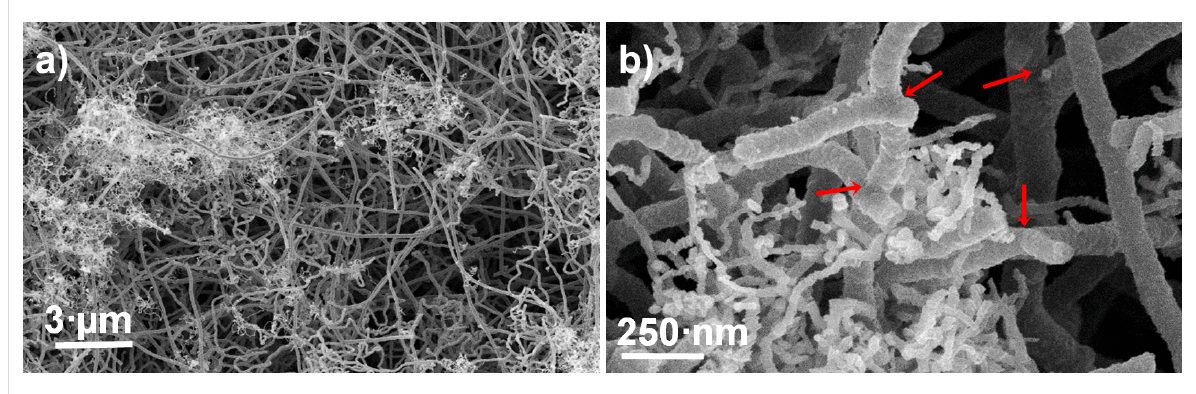
Figure 2: SEM micrographs showing the entangled structure of the network acquired at two different magnifications (a,b). The red arrows in panel (b) point to junctions between CNTs.